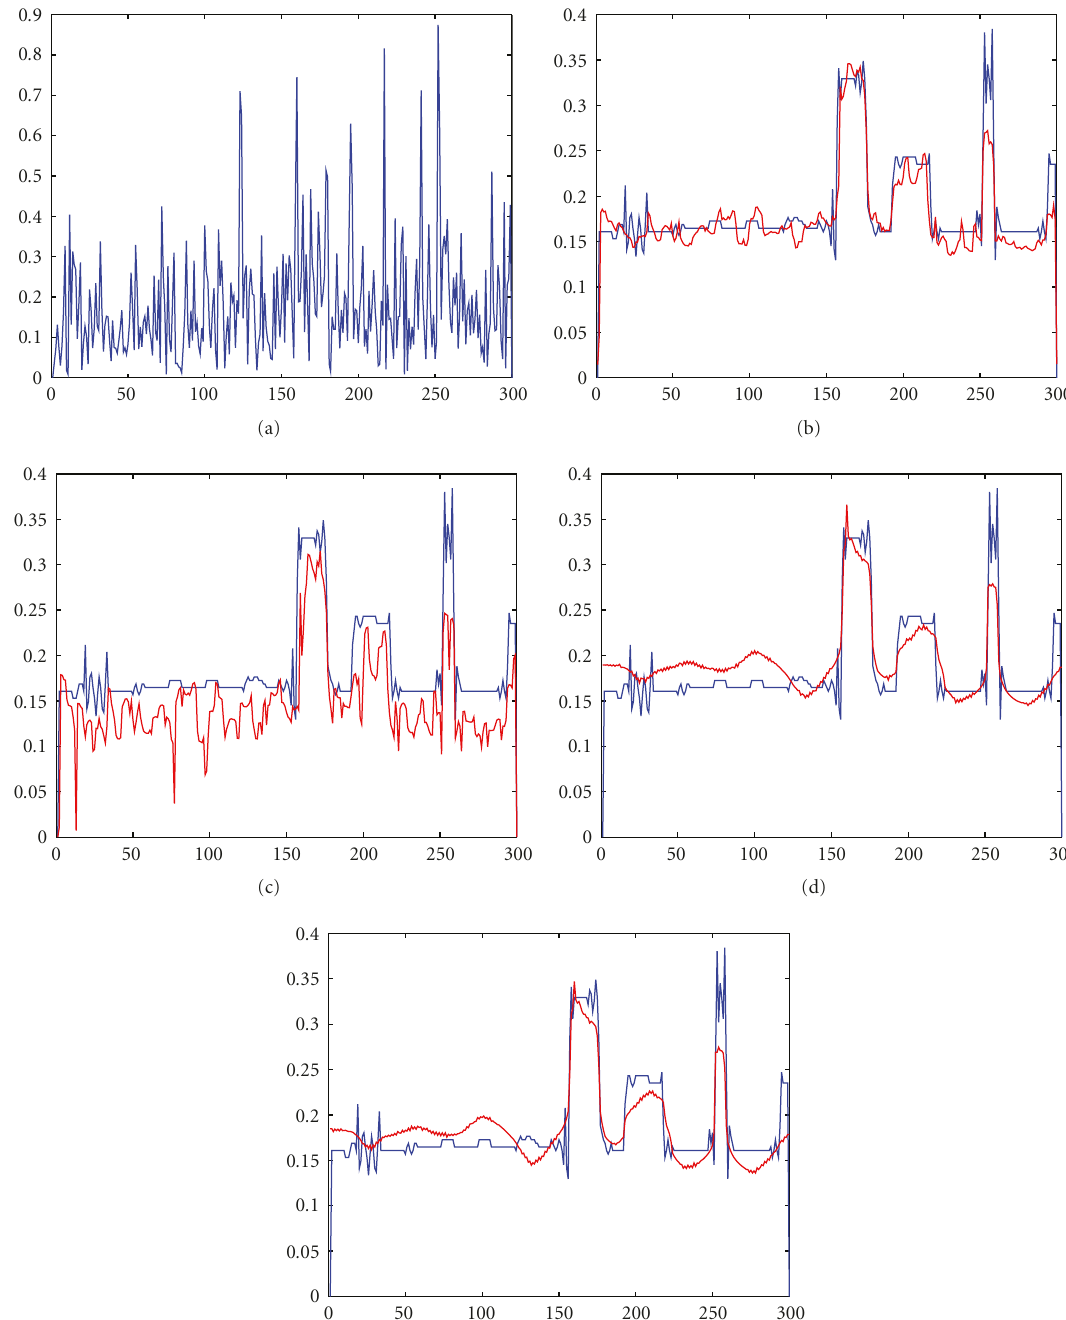
Figure 10: The 128th line of the original, noisy, and restored images for denoising Figure 3(a). (a) The noisy image; (b) the slice restored by the proposed method; (c) the slice restored by the “HMW” method; (d) the slice restored by the “AA” method; (e) the slice restored by the “RLO” method. Here the blue line is the original image, and the red line is the restored image.